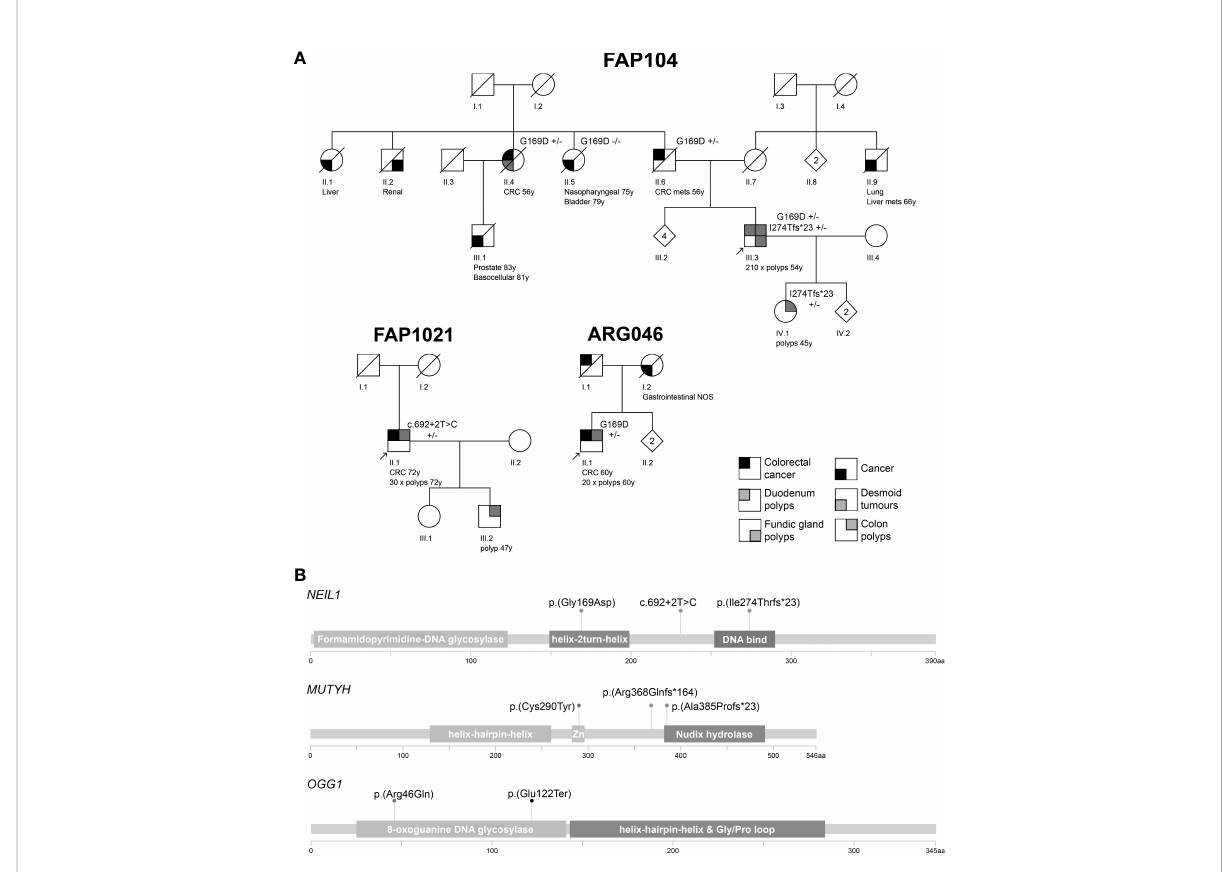
FIGURE 2 (A) Pedigrees of the polyposis families with NEIL1 variants. Numbers below the symbols are patient identi fi ers. Arrow denotes the index person. Zygosity of NEIL1 variants is shown (+/ − heterozygous). Tumor manifestations and age at diagnosis (years) are given below the patient symbol. Mets refers to metastasis. Nonessential pedigree features were removed or modi fi ed to protect con fi dentiality. (B) Locations of the variants relative to the main functional domains of the DNA glycosylase genes. Zn denotes the metal binding sites in MUTYH as listed in the Uniprot database (www.uniprot.org; Q9UIF7). The pedigrees were generated with Pedigree Chart Designer and the lollipop diagrams with